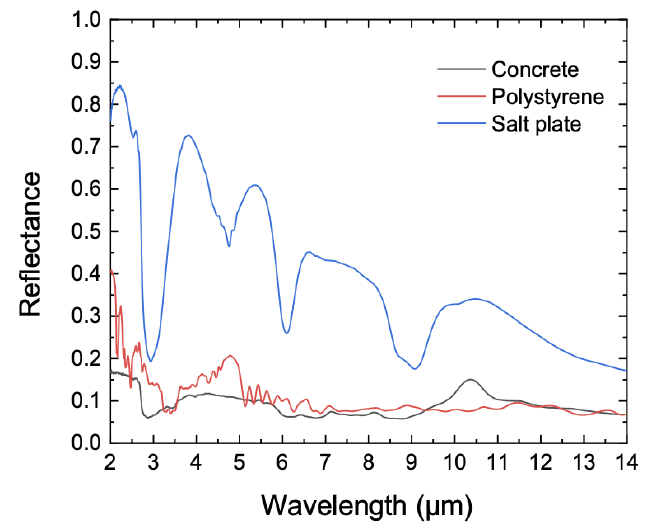
Figure 9. Spectral diffuse reflectance of the homemade SDR (Korea Research Institute of Standards and Science (KRISS)) compared to that by National Institute of Standards and Technology (NIST).